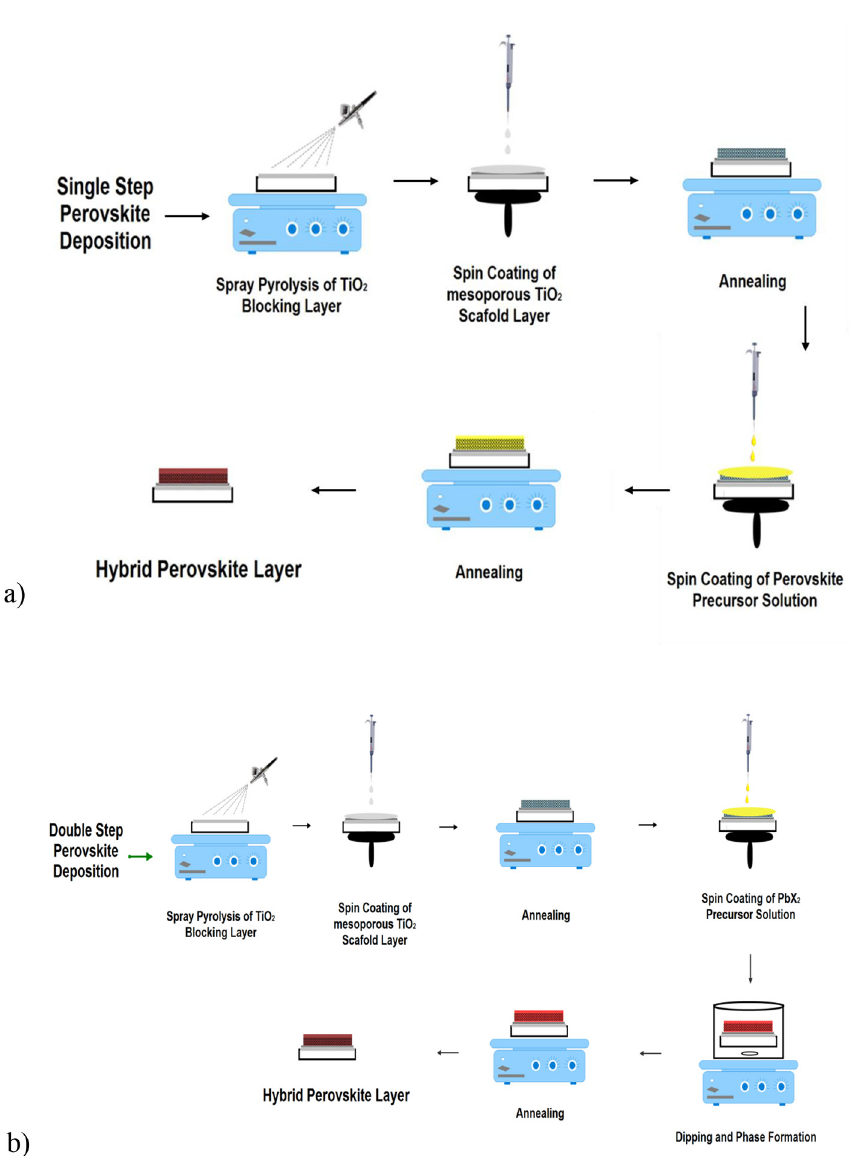
Fig. 14. – Single step (a) vs. double step (b) perovskite layer deposition. step process further improved the perovskite quality and promoted the PCE to about 19% [96]. Recently, by applying a new Pb-I precursor of PbI 2 (DMSO), high-quality FAPbI 3 /MAPbBr 3 perovskite was obtained through intramolecular exchange between FA/MA with DMSO, which boosted the PCE to over 20% [97]. Therefore, the two-step method has been well proved to be an effective approach to synthesize high-quality thin perovskite for high-performance PSCs even out of the